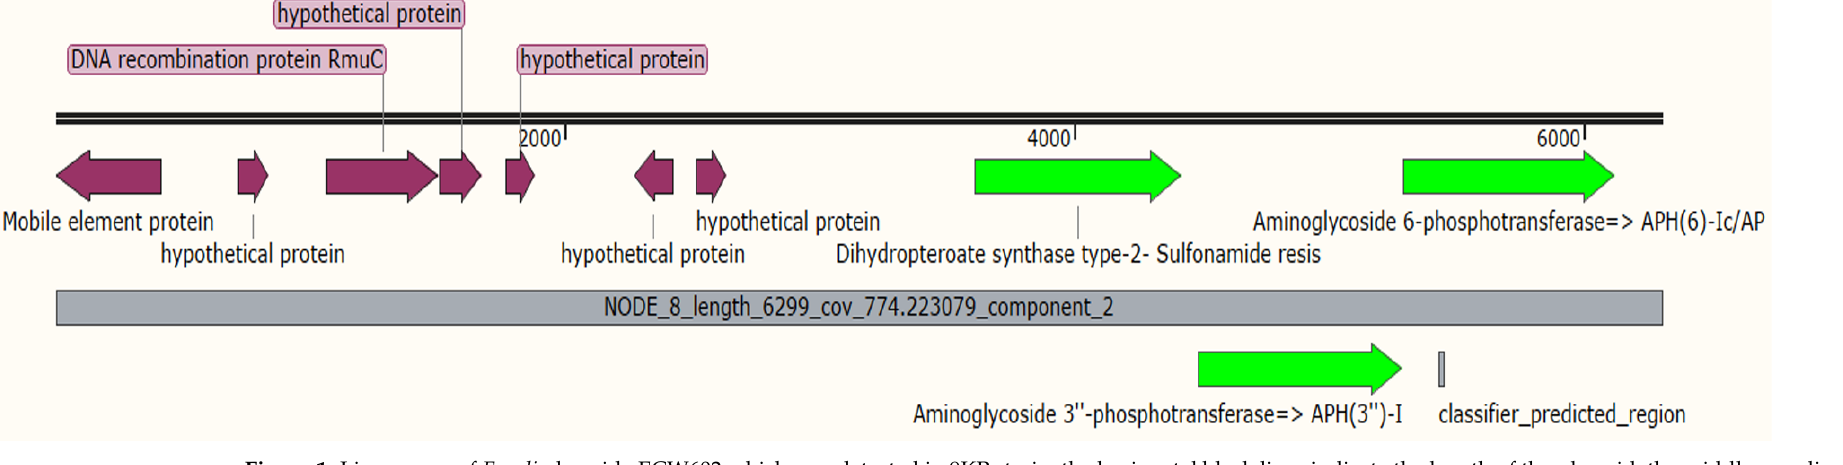
Figure 1. Linear map of E. coli plasmid p ECW602 which was detected in 9KP strain; the horizontal black lines indicate the length of the plasmid, the middle gray line contains information about plasmid length and coverage. In addition, the purple arrows indicate mobile elements and hypothetical proteins. The green arrows indicate ARGs. Table 2. Comparison of virulence factors of K. pneumoniae 9KP with other control strains ( K. pneumoniae 342, MGH 78578, NTUH-K2044, 1084, HS11286, JM45, KCTC 2242, SB3432) and the most related strains (kkp066, kkp0e6, and 23KE).